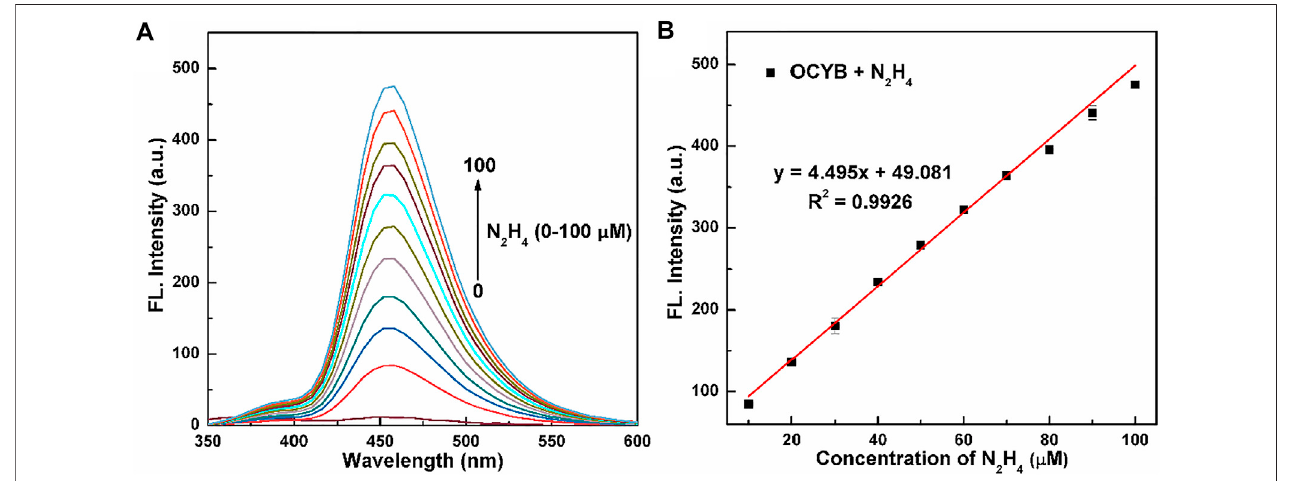
FIGURE3| Fluorescence spectra (A) ofOCYB (10 μ M) withaseries ofconcentrationsofN 2 H 4 (0 – 100 μ M) inDMSO-HEPES buffer solution(1:1,v/v, pH 7.4, λ ex = 330 nm).Thelinearrelationshipbetweenthe fl uorescenceintensity (B) ofOCYBandtheN 2 H 4 concentration(0 – 100 μ M).Dataareshownasthemean±SE(bars)( n =3).